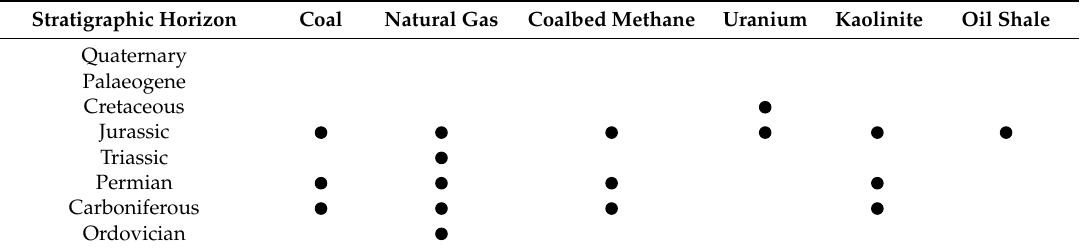
Table 1. Stratigraphic horizons for some of the main minerals in the Ordos